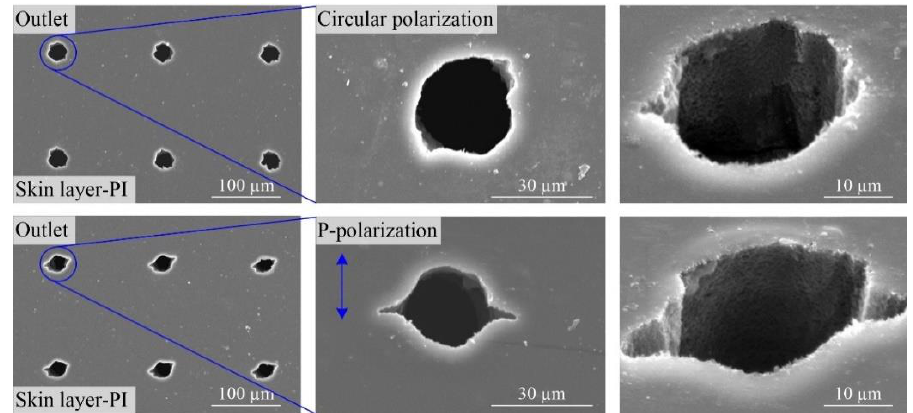
Figure 6. Scanning electron microscopy (SEM) images of through-holes with different laser polarizations in single-sided board with the laser wavelength of 532 nm (Energy of 0.007 mJ, 1000 pulses).